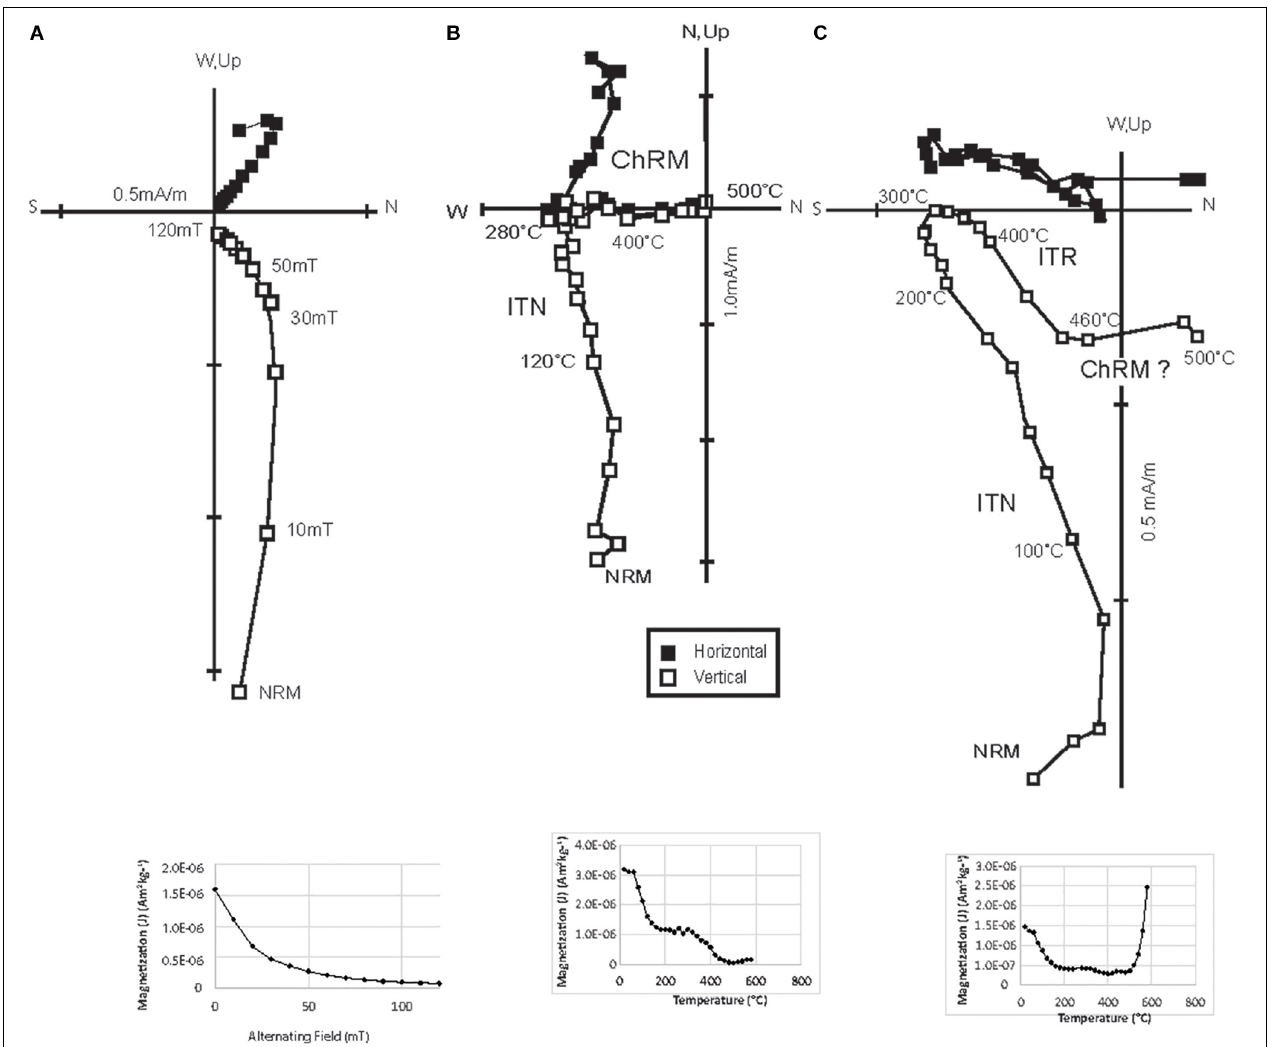
FIGURE 4 | Representative orthogonal projections and NRM decay plots for DB. (A) AF demagnetization of specimen from DB, (B) Thermal demagnetization of a DB specimen showing the ITN and the ChRM, (C) DB specimen showing the ITN and ITR components and a possible ChRM. The magnetization increases above 500 ◦ C because of creation of new minerals (e.g., magnetite) and these temperature steps were removed from the orthogonal projection but not on the thermal decay